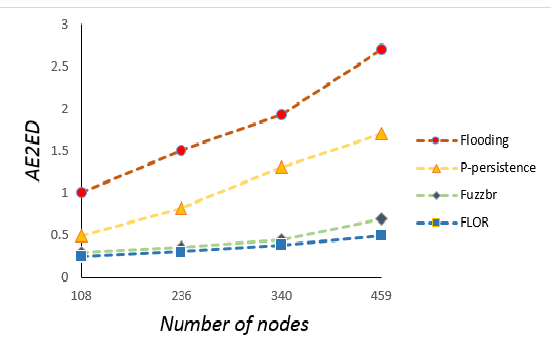
Figure 8. End-to-end latency for different numbers of vehicles.